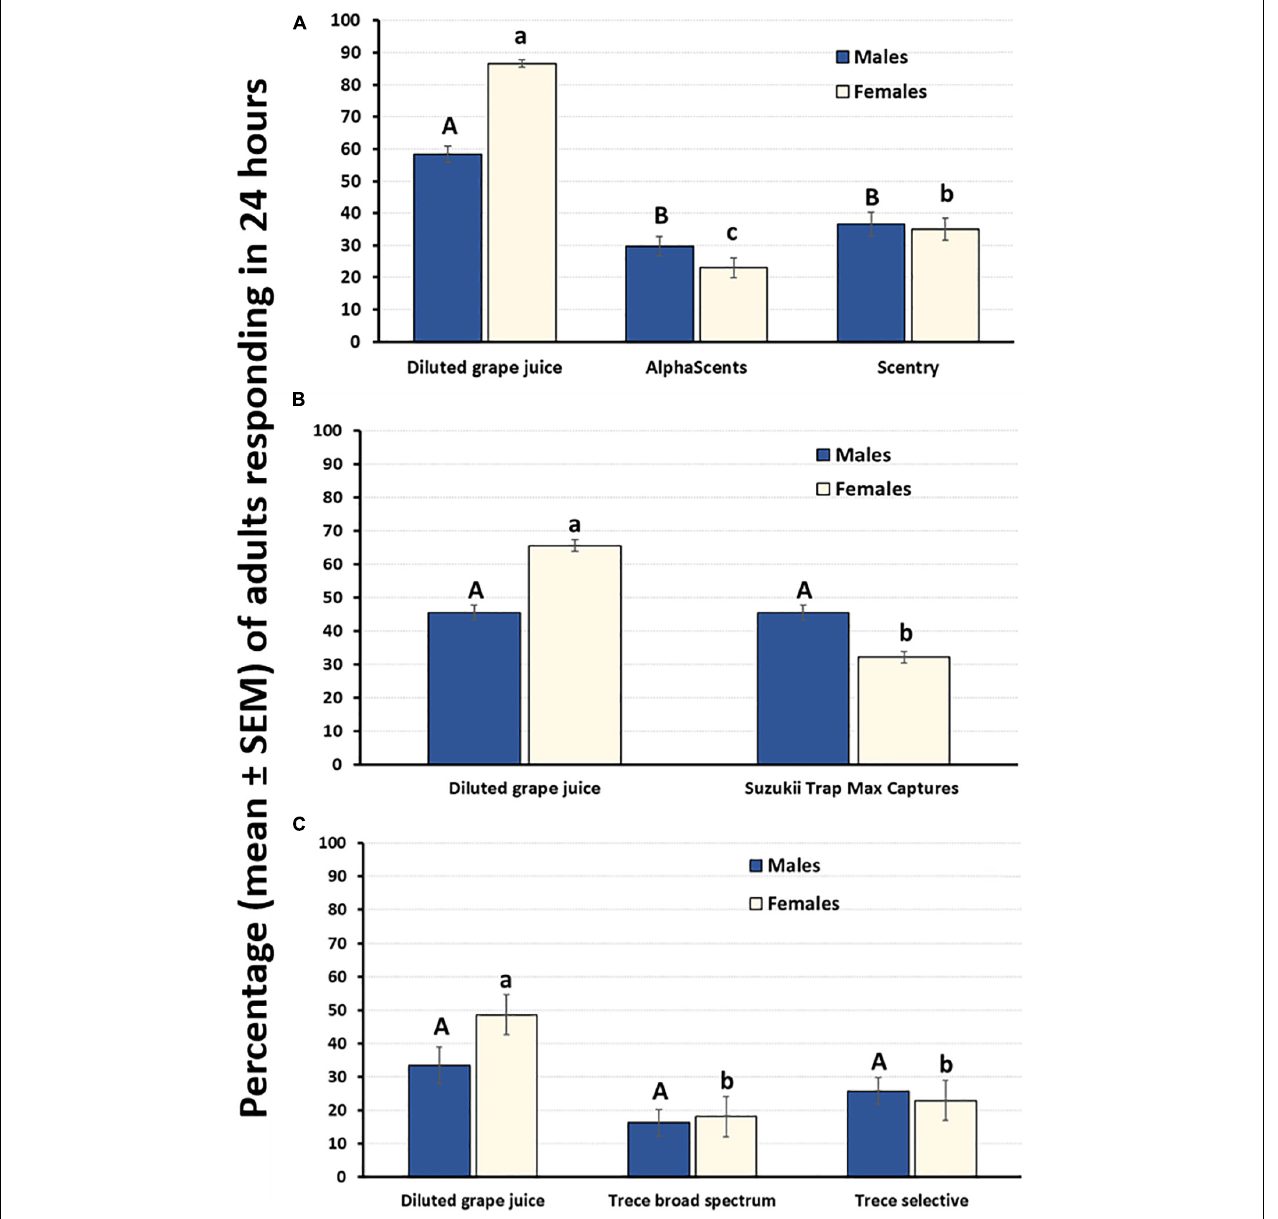
FIGURE 1 | Response, expressed as the mean percentage ( ± SEM) of male and female D. suzukii captured over a 24-h period in cage tests, to fresh diluted Concord grape juice and commercial D. suzukii lures and baits: (A) Scentry R (cid:13) SWD and AlphaScents R (cid:13) SWD, (B) Suzukii Trap Max Captures bait, and (C) Trécé broad spectrum and selective lures. For each sex, means superscribed by different letters (uppercase = treatment comparison among males; lowercase = treatment comparison among females) indicate significant differences according to ANOVA and Tukey HSD tests and t -tests at P = 0.05.